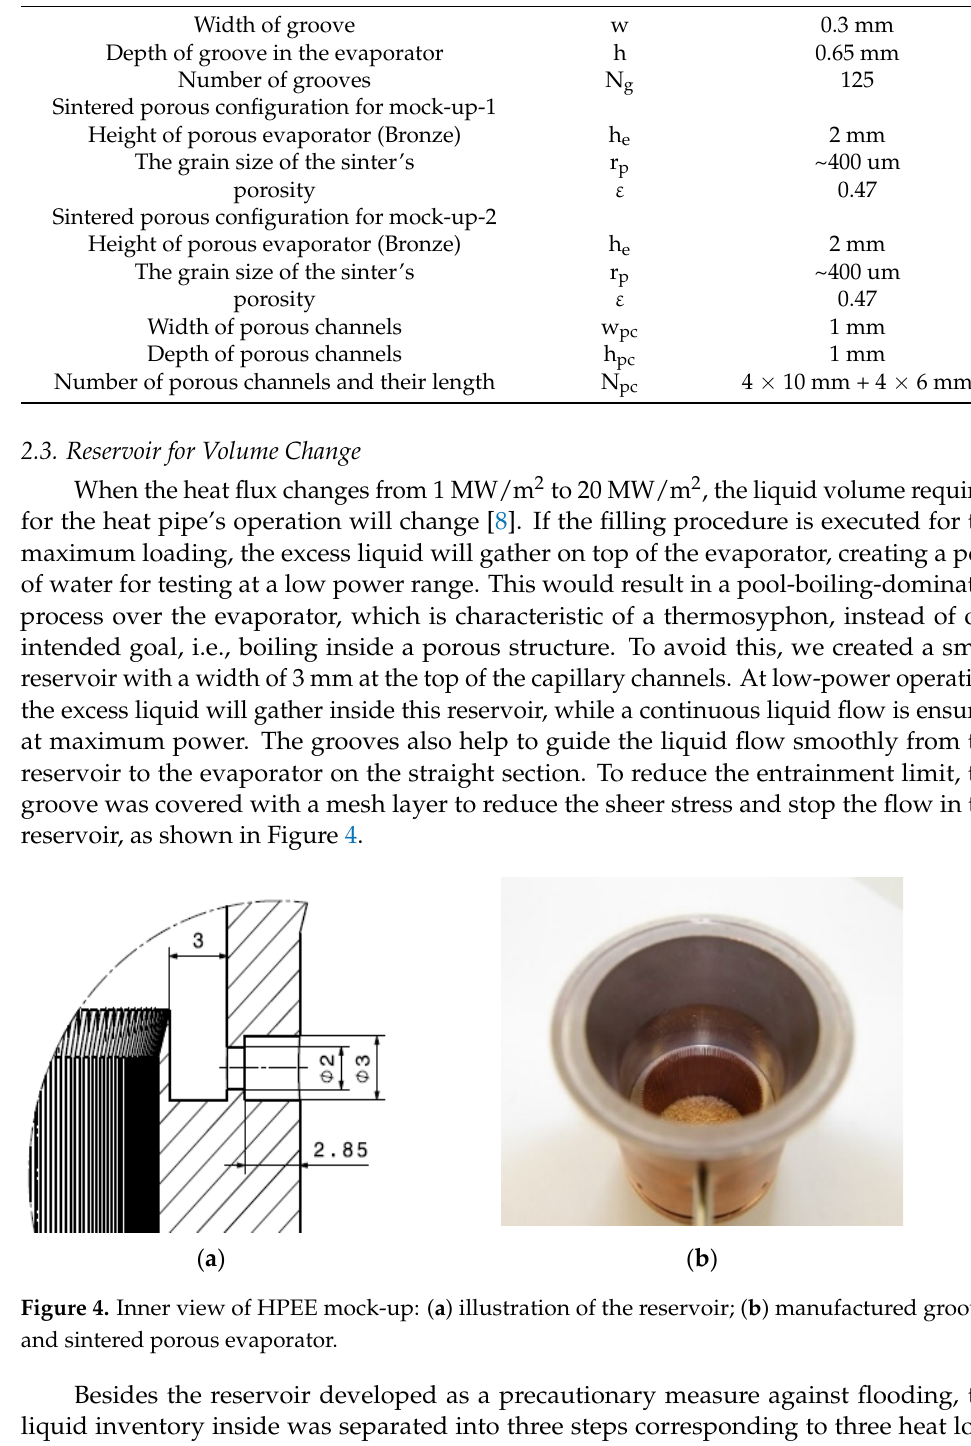
Table 2. The heat load ranges with their corresponding liquid inventories.